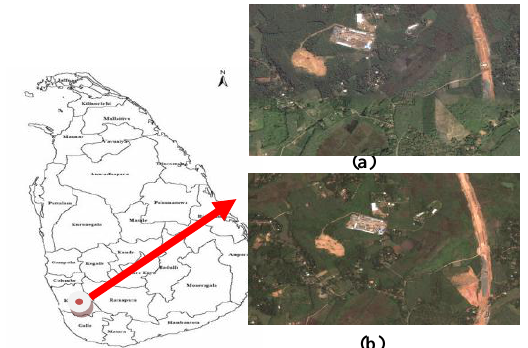
Fig.1. Google map image of the Study site in the west coast of